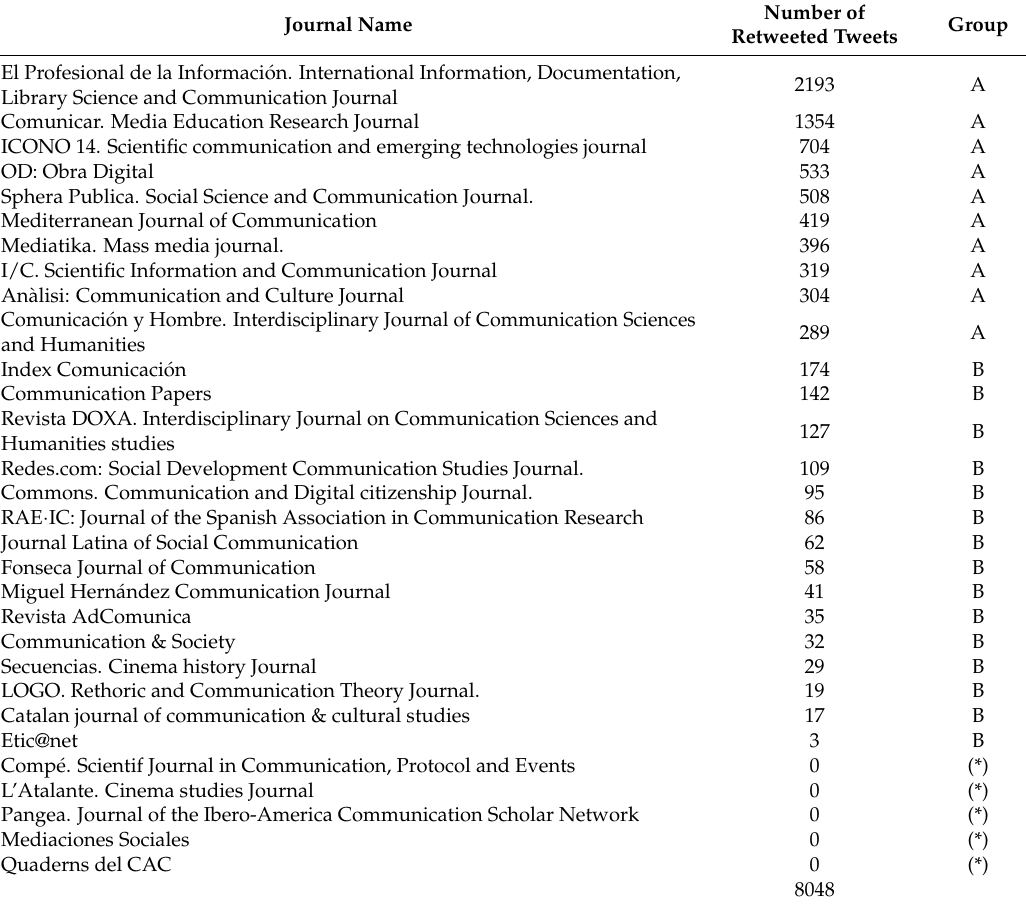
Table 2. Journal classification according to number of retweeted